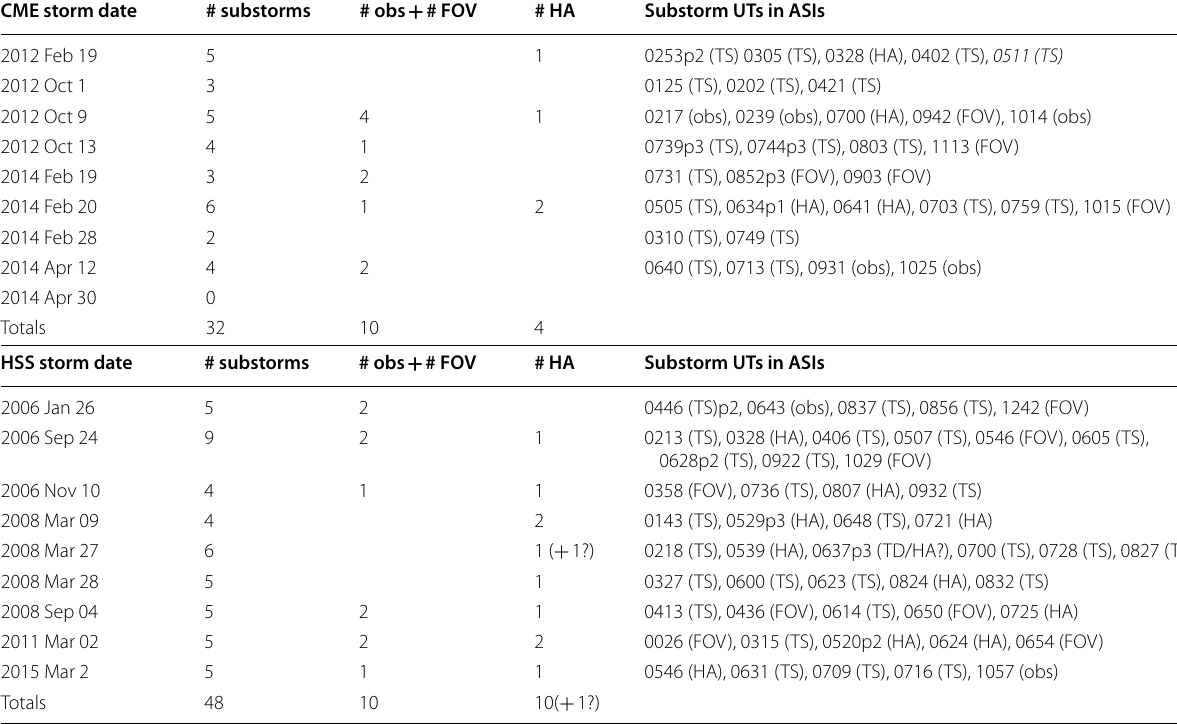
Pseudo-breakups are identified by a maroon p followed by 1, 2, or 3, which give the observed degrees of latitude of pseudo-breakup poleward expansion. The attributes are TS (tilted streamer); HA (Harang streamer); Ob: (onset obscured by moon, clouds, or trees); FOV (onset detected by initial brightening slightly beyond ASI